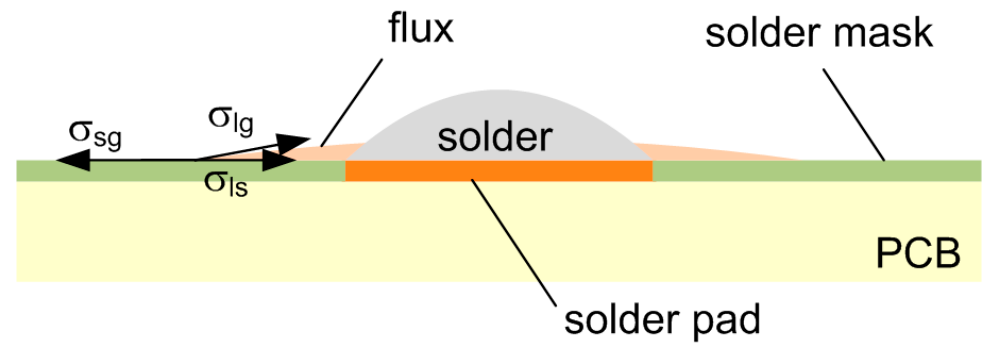
Figure 1. Surface tension equilibrium diagram, where σ sg (Nm − 1 ) is the surface tension between solid and gas, σ ls (Nm − 1 ) is the surface tension between liquid and solid, σ lg (Nm − 1 ) is the surface tension between liquid and gas.